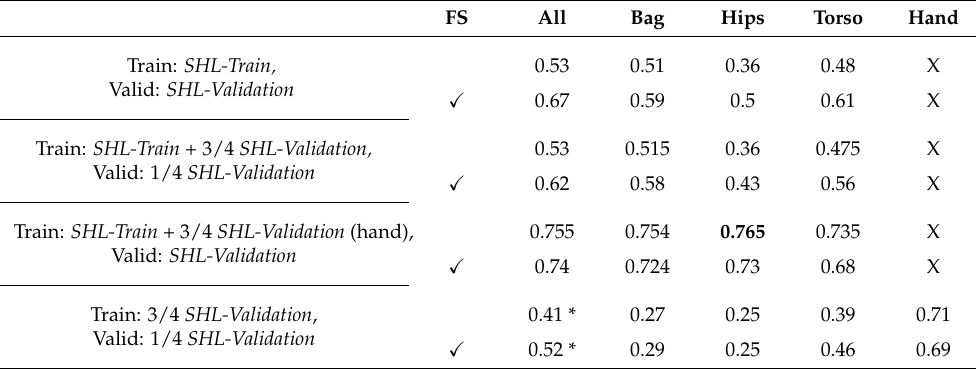
Table 5. Comparison of the F1 scores obtained using different combinations of training data for 2019. For each training combination, we tested whether the adaptation of the features to the hand location improves the results. All the results listed in this table were obtained using only instances from the hand location when testing. For the last combination, where data only from the SHL-Validation set were used, * denotes that no instances from hand location were used for